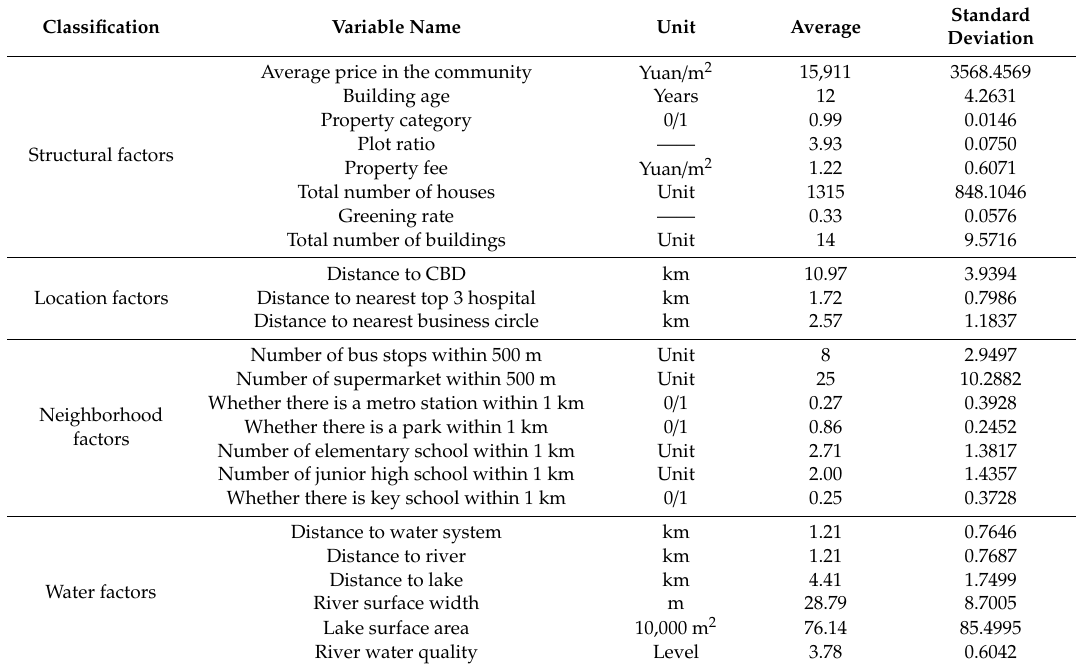
Table 2. Description of the data